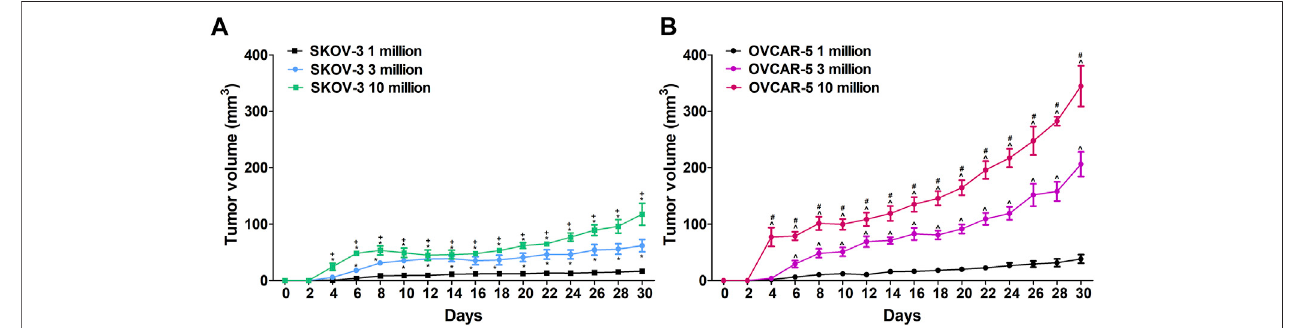
FIGURE 1 | (A) Difference in ovarian SKOV-3 and OVCAR-5 cancer ectopic xenograft tumor growth following 1, 3 and 10 × 10 6 cells subcutaneous administration in immunocompromised SCID-SHO female mice. (B) Increase in tumor growth was shown following administration of 10 million ovarian (OVCAR-5) cancer cells relative to 1 or 3 million in immunocompromised SCID-SHO female mice. Symbols represent the means ± SEM. (1 million, n = 8 for SKOV3, n = 11 for OVCAR5 in SCID-SHO females;3million, n =6forSKOV3,n=9forOVCAR5 inSCID-SHO females;10million, n =8forSKOV3, n =10forOVCAR5inSCID-SHO females). * p < 0.037for SKOV-3 10 or 3 million vs SKOV-3 1 million (repeated measures one-way ANOVA with Bonferroni post hoc); + p < 0.044 for SKOV-3 10 million vs SKOV-3 3 million (repeated measures one-way ANOVA with Bonferronipost hoc); ^ p < 0.02 for OVCAR-5 10 or 3 million vs OVCAR-5 1million (repeated measures one-way ANOVA with Bonferroni post hoc; # p < 0.011 for OVCAR-5 10 million vs OVCAR-5 3 million (repeated measures one-way ANOVA with Bonferroni post